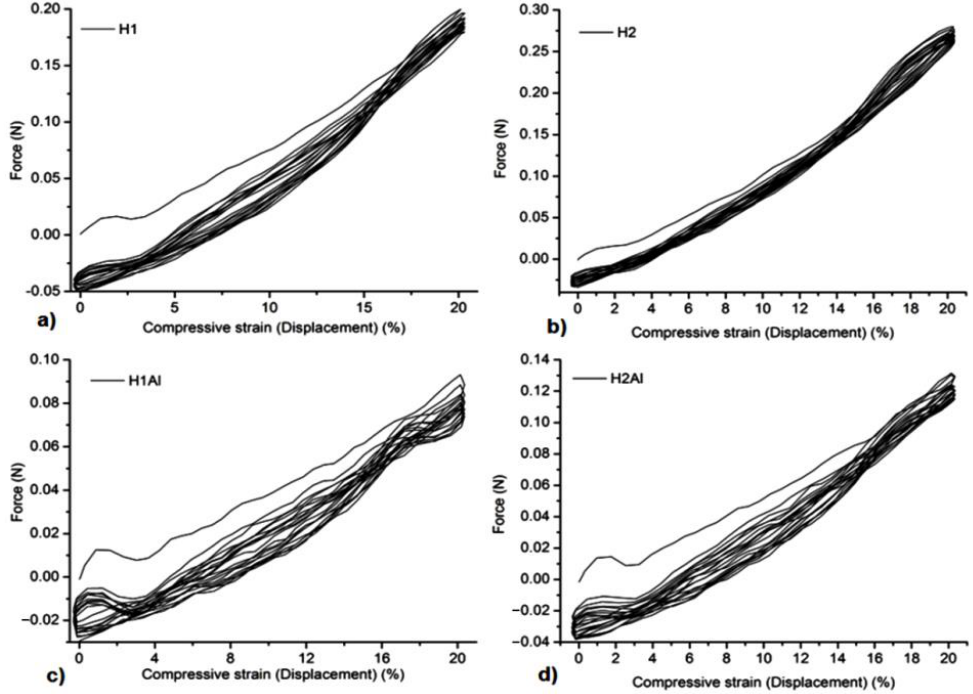
Figure 6. The dependence of Force/compressive strain% of the samples: a ) — H1, b ) — H2, c ) — H1Al, and d ) — H2Al.